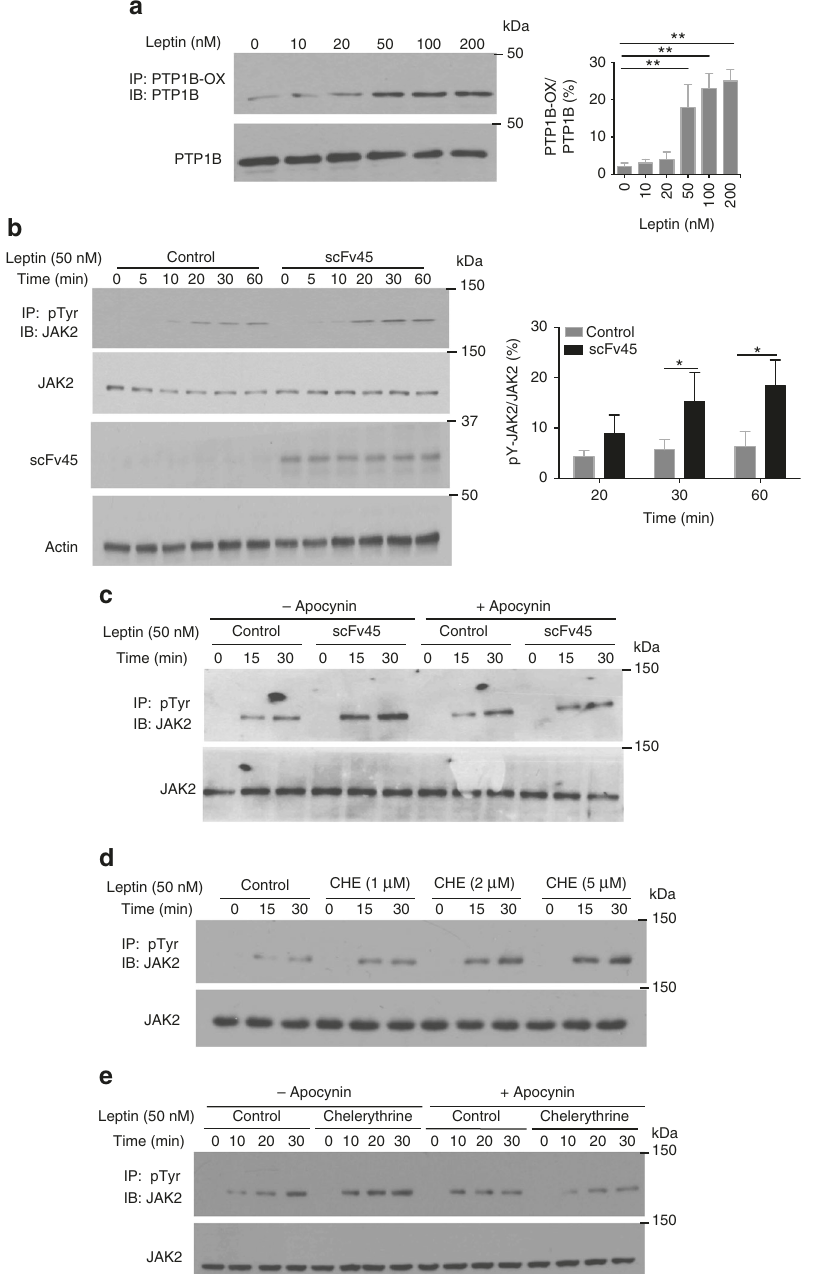
Fig. 7 Chelerythrine enhanced leptin signaling in a redox-dependent manner. a Hepatic stellate cells were stimulated with varying concentration of leptin (0 – 200 nM), cells were lysed and lysates were used to immunoprecipitate oxidized PTP1B using HA-tagged scFv45. b Hepatic stellate cells that transiently express scFv45 or vector control were stimulated with leptin for varying lengths of time (0 – 60 min) following which cells were lysed and lysates were used to study leptin signaling by immunoblot analysis. c Hepatic stellate cells that transiently express scFv45 or vector control were incubated without or with apocynin for 60 min, following which cells were stimulated with leptin for varying lengths of time (0 – 30 min), lysed, and lysates were used to study leptin signaling by immunoblot analysis. d Hepatic stellate cells were treated with varying concentrations of chelerythrine (0 – 5 μ M), stimulated with leptin for varying lengths of time (0 – 30 min), then lysed, and lysates were used to study leptin signaling by immunoblot analysis. e Hepatic stellate cells were incubated with or without apocynin and chelerythrine for 60 min, following which cells were stimulated with leptin for varying lengths of time (0 – 30 min), then were lysed, and lysates were used to study leptin signaling by immunoblot analysis. All immunoblots are representative of three independent experiments ( n = 3). Immunoblots were quanti fi ed using ImageJ software. Quantitation includes the data from all experiments and is presented as